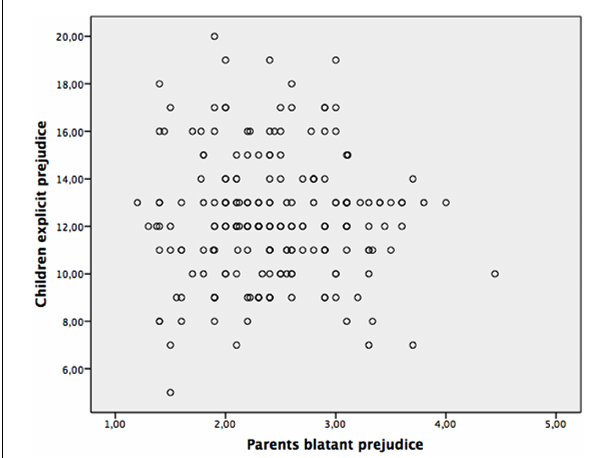
FIGURE 1 | Scatterplot of relations between parents subtle prejudice and children implicit prejudice (IAT).